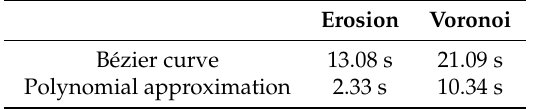
Table 6. Mean run time of the different combination of the methods in seconds for a single